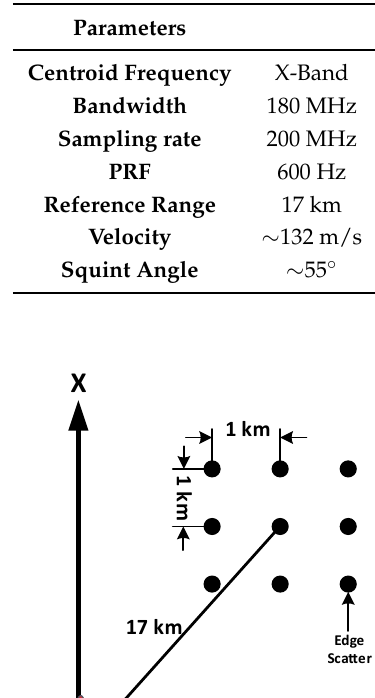
Table 1. Simulated parameters of airborne squint SAR.